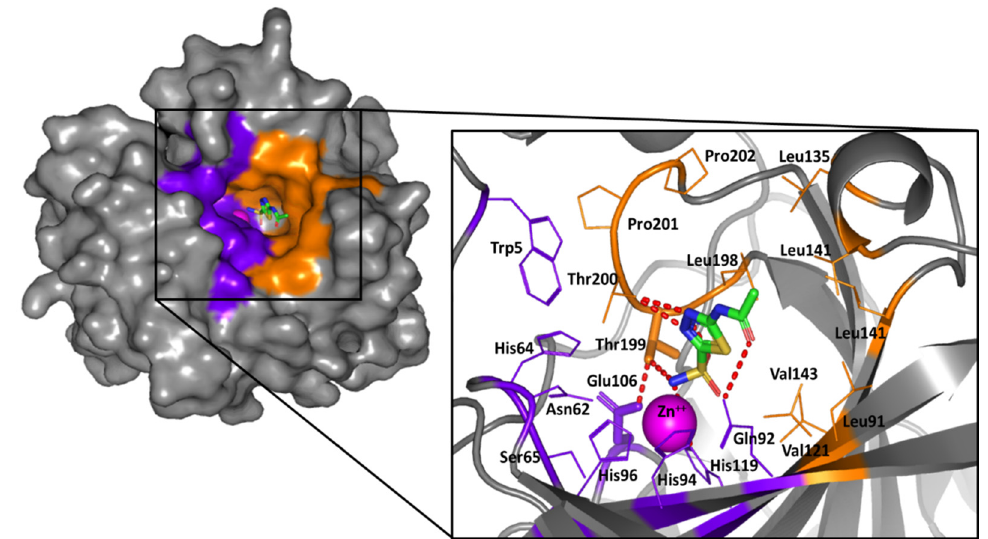
Figure 6. The surface rendition of h CA-IX (PDB ID: 3iai) in gray representation, illustrating the deeply anchored co-crystallized acetazolamide (sticks) into the active site cleft; the prosthetic Zn(II) (magenta sphere), as well as the hydrophilic (purple) and hydrophobic (orange) residues are shown. The zoomed image is the stereo view of acetazolamide (sticks; green as carbon, red as oxygen, blue as nitrogen, yellow as sulfur) occupying the chemically significant active site permitting tetrahedral coordination to Zn(II) and the histidine triad (His94, His96, His119). Hydrogen bonding is depicted as red dashed lines. Only residues located within 5Å radius of bound ligand are displayed as lines (except gate keepers-Thr199 and Glu106-as sticks) and labeled with sequence number.